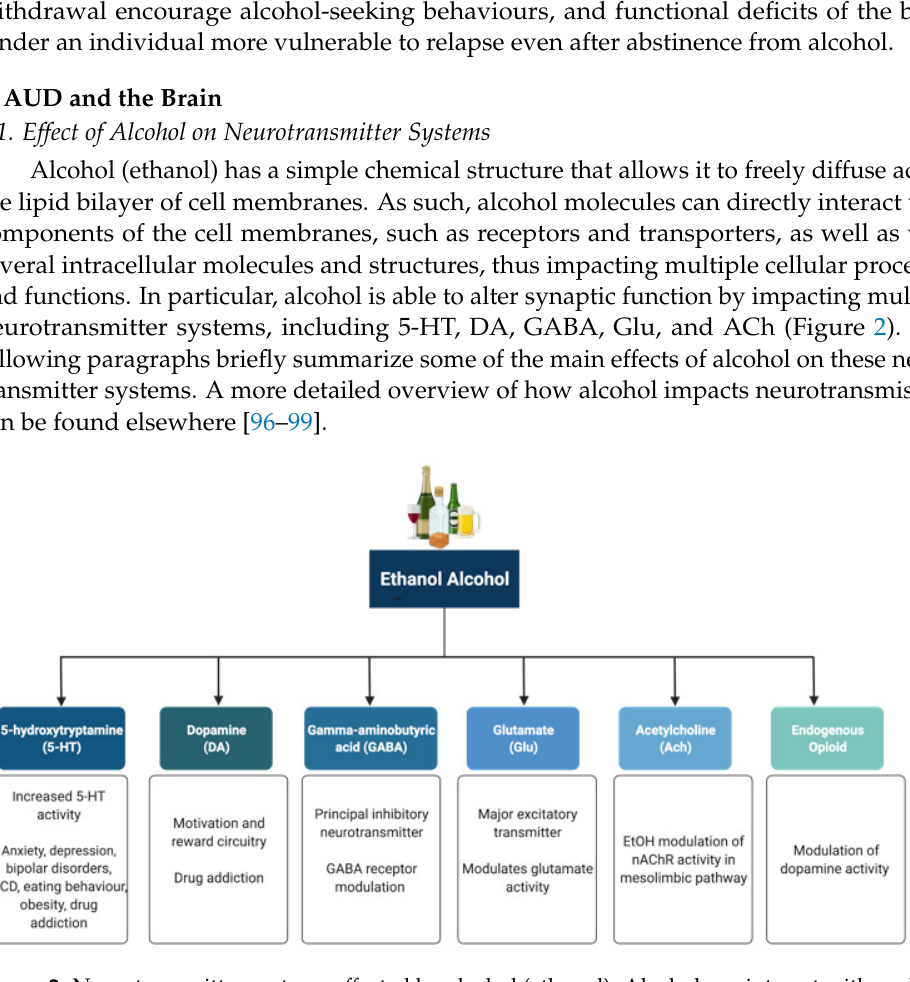
Figure 2. Neurotransmitter systems affected by alcohol (ethanol). Alcohol can interact with multiple neurotransmitter systems in the brain, including the serotonergic (5-HT), dopaminergic (DA), gamma-amynobutyric acid (GABA)-ergic, glutamatergic (Glu), Acetylcholinergic (ACh), and opioid systems, disrupting synaptic transmission and signalling and resulting in the dysregulation of neuronal networks that control reward, motivation, decision making, affect, and the stress response.